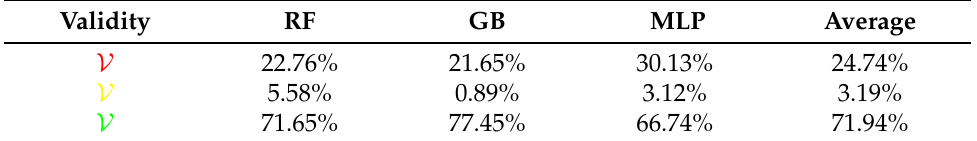
Table 9. Rate of validity of RHOASo vs. HPO across all D i (% with accuracy and time complexity).